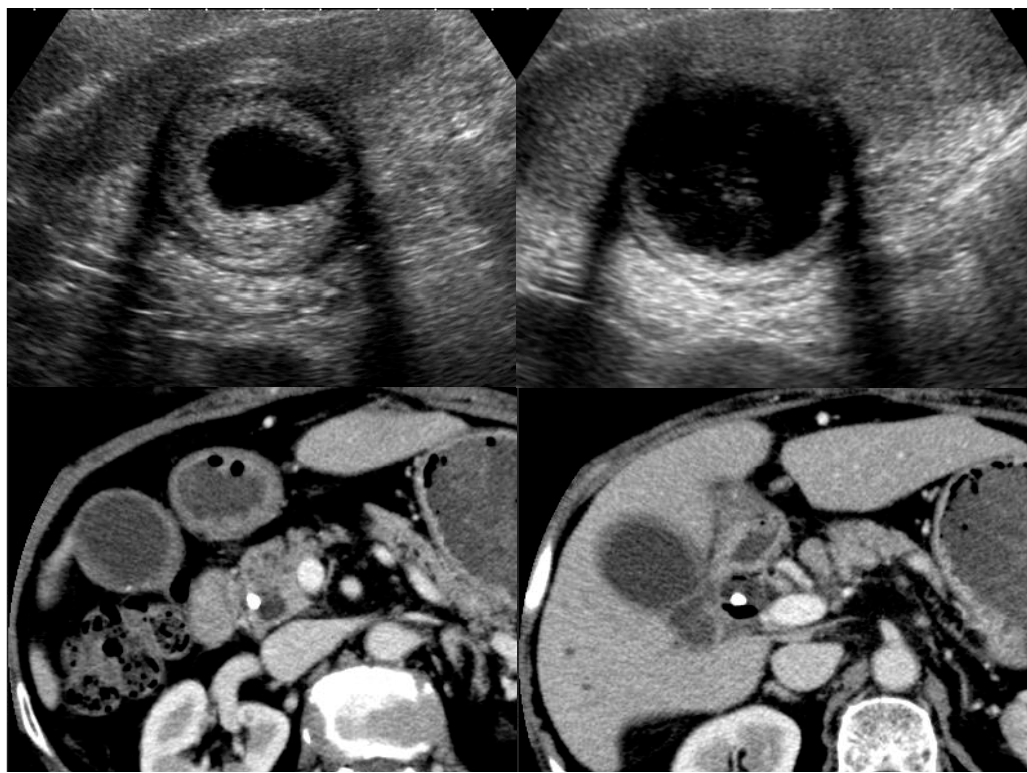
Figure 4. US (3-layer type) and CT (1-layer type) findings of a case with a diffuse type of IgG4-sclerosing cholecystitis. Computed tomography (CT) (Figure 5):